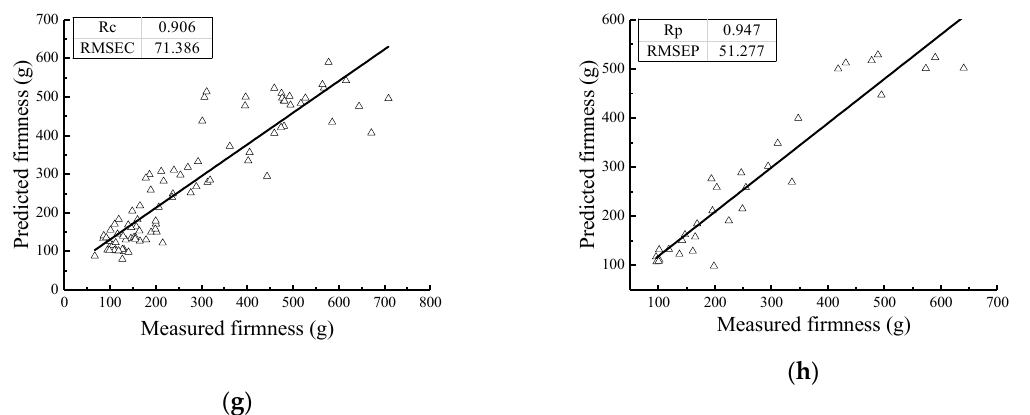
Figure 11. Prediction results of the firmness of the pears using the PLS method at different holding times: ( a ) the MSC calibration set; ( b ) the MSC validation set; ( c ) the S-G-MSC calibration set; ( d ) the S-G-MSC validation set; ( e ) the S-G-SNV calibration set; ( f ) the S-G-SNV validation set; ( g ) the SNV calibration set; and ( h ) the SNV validation set.